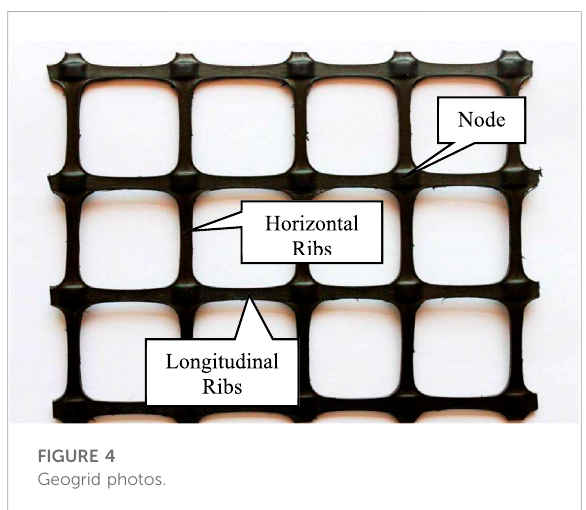
FIGURE 3 Photographs and grain grading curves of the coarse-grained